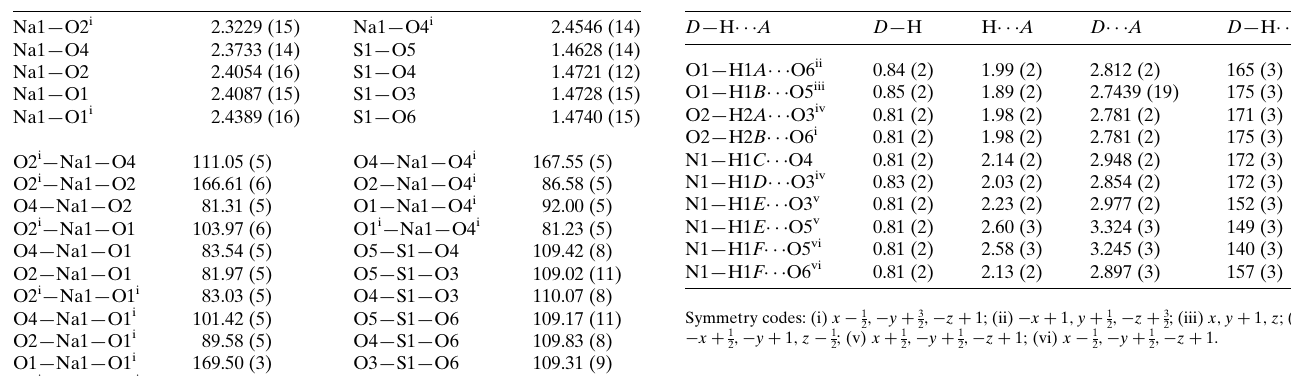
Table 1 Selected geometric parameters (A˚ , (cid:5) ).